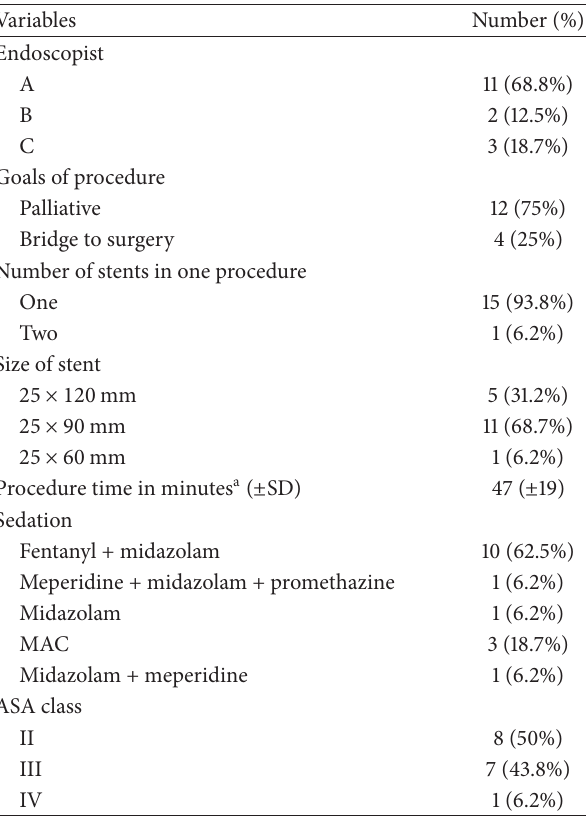
Table 2: Procedural specifications. Table 3: Procedure